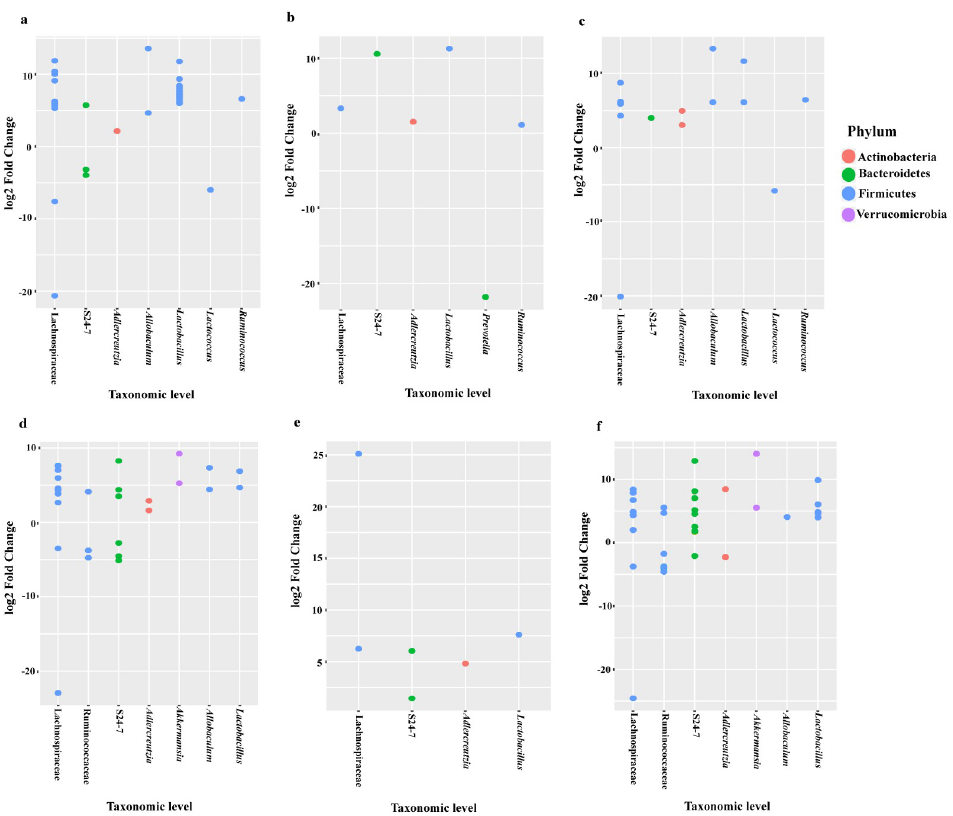
Fig 6. Dotplots showing the difference between relative abundance of microbial species after the onset of tumor in mice. (a) Dotplot of the bacterial abundance between BSp-fed and control-fed, (b) GTPs-fed and control-fed, (c) combination-fed and control-fed mice after tumor onset in the BE group (n = 8). (d) Dotplot of the microbial species abundance between mice on BSp and control, (e) GTPs and control, (f) combination and control dietary treatments after tumor onset in LC group (n =